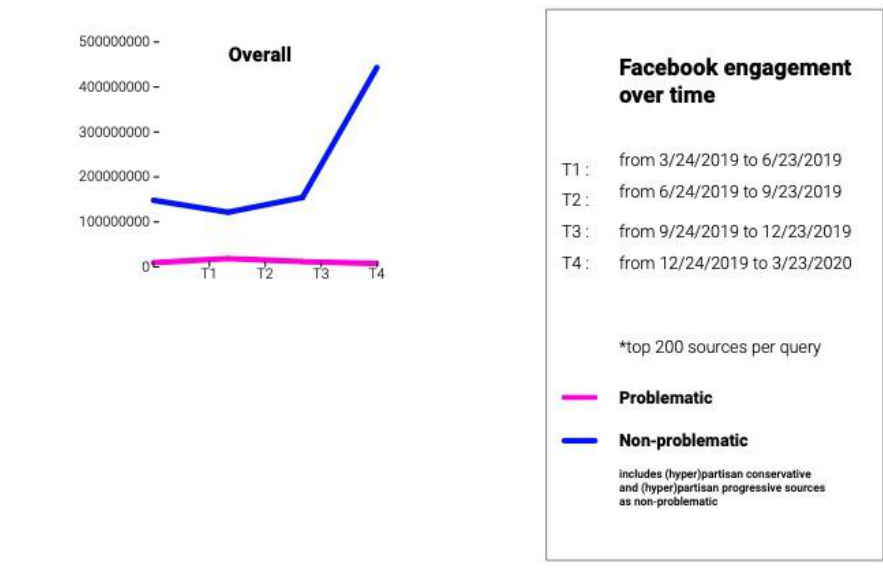
Figure 5. Facebook engagement scores of ‘fake news’ (narrow definition) versus mainstream news for political candidate and social issue queries overall, March 2019 - March 2020. Source: